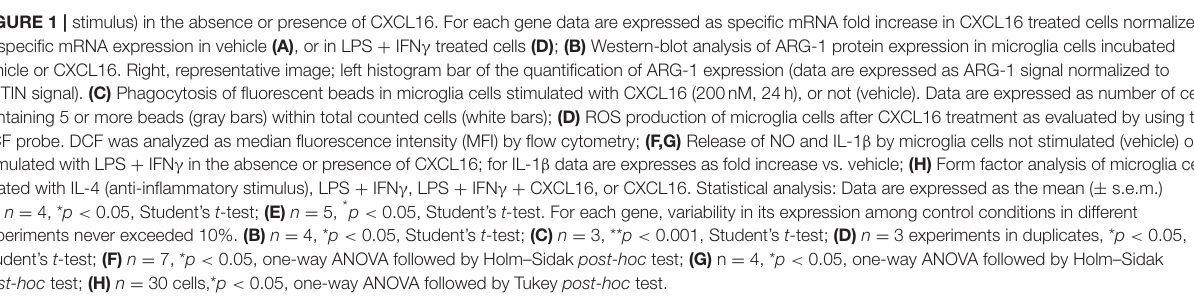
FIGURE 1 | stimulus) in the absence or presence of CXCL16. For each gene data are expressed as specific mRNA fold increase in CXCL16 treated cells normalized to specific mRNA expression in vehicle (A) , or in LPS + IFN γ treated cells (D) ; (B) Western-blot analysis of ARG-1 protein expression in microglia cells incubated vehicle or CXCL16. Right, representative image; left histogram bar of the quantification of ARG-1 expression (data are expressed as ARG-1 signal normalized to ACTIN signal). (C) Phagocytosis of fluorescent beads in microglia cells stimulated with CXCL16 (200nM, 24h), or not (vehicle). Data are expressed as number of cells containing 5 or more beads (gray bars) within total counted cells (white bars); (D) ROS production of microglia cells after CXCL16 treatment as evaluated by using the DCF probe. DCF was analyzed as median fluorescence intensity (MFI) by flow cytometry; (F,G) Release of NO and IL-1 β by microglia cells not stimulated (vehicle) or stimulated with LPS + IFN γ in the absence or presence of CXCL16; for IL-1 β data are expresses as fold increase vs. vehicle; (H) Form factor analysis of microglia cells treated with IL-4 (anti-inflammatory stimulus), LPS + IFN γ , LPS + IFN γ + CXCL16, or CXCL16. Statistical analysis: Data are expressed as the mean ( ±